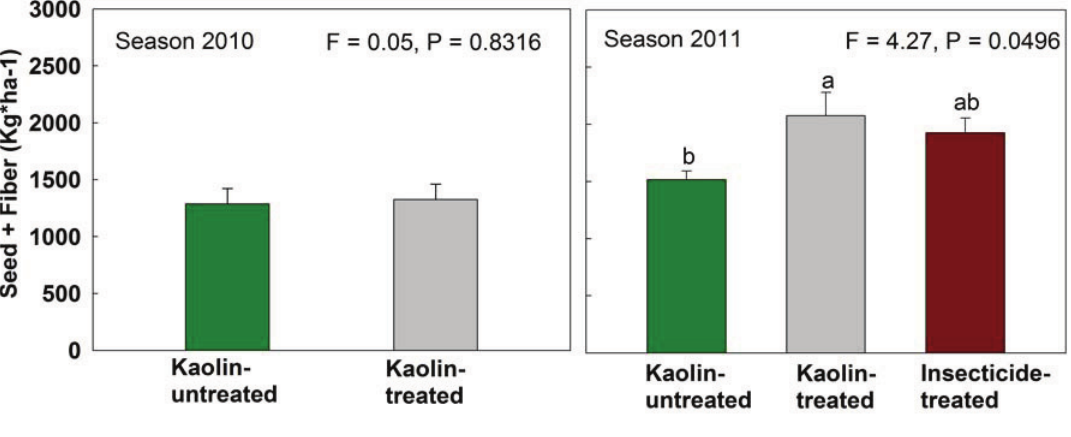
Figure 3. Cotton yield (seeds + fiber) from kaolin-untreated and kaolin-treated 2010 season, and kaolin-untreated, kaolin-treated and insecticide-treated 2011 season. Bars (+SE) under the same letters do not differ statistically by Tukey HSD’s test ( p >